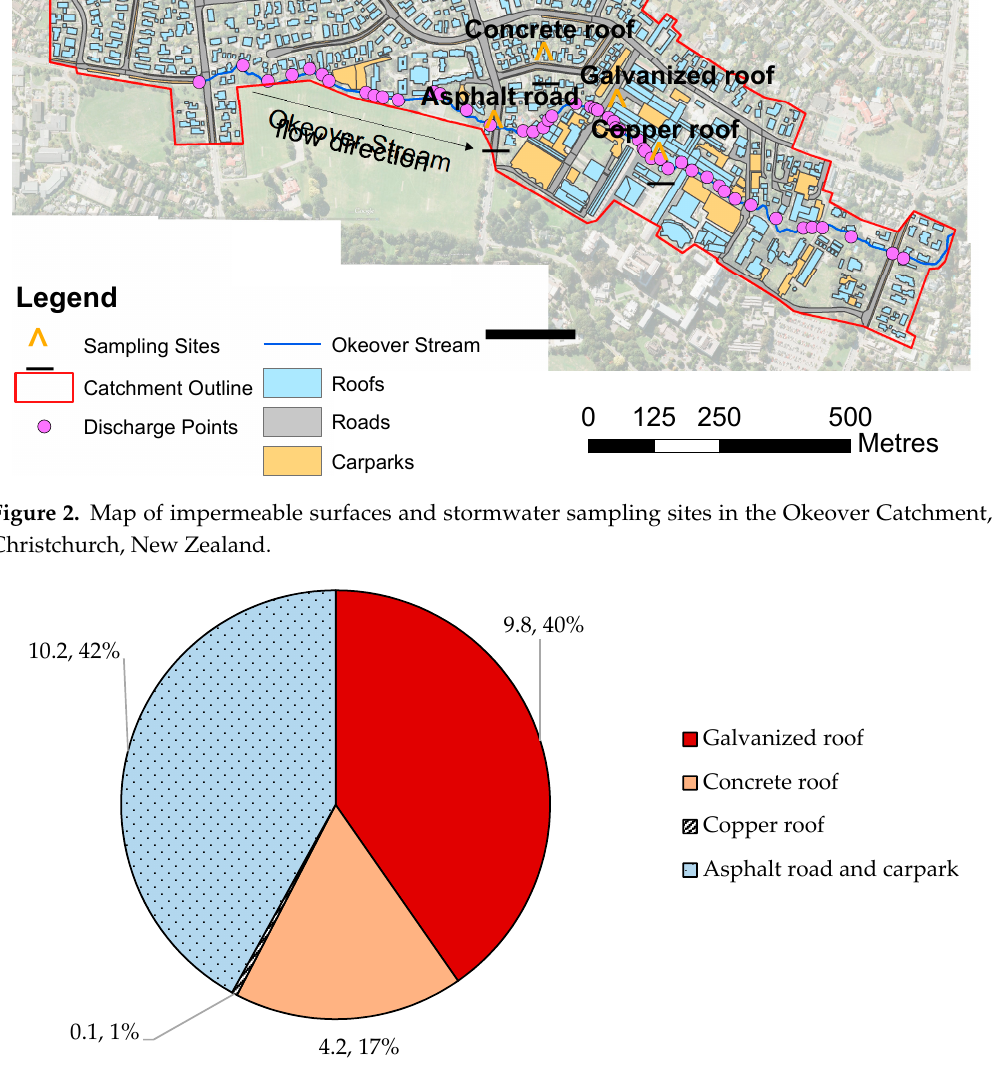
Figure 3. Relative impermeable area (ha) and percentage of surface type.